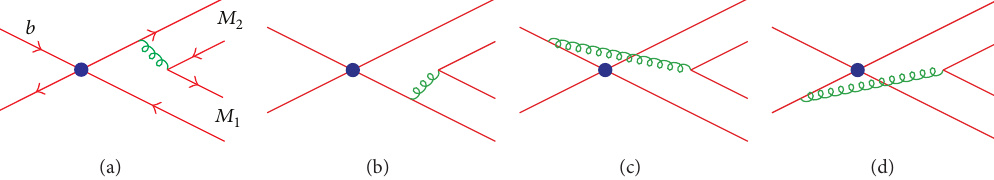
Figure 2: Order of 𝛼 𝑠 corrections to the weak